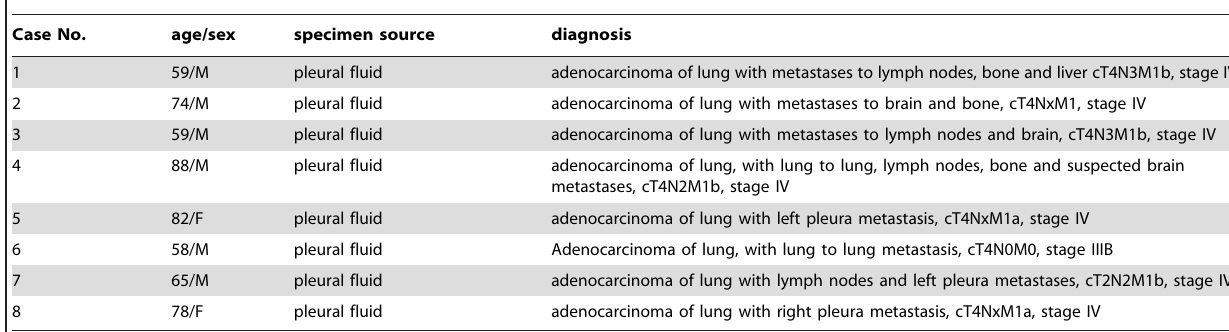
Table 6. Clinical data and cytological diagnosis of eight MPE specimens.